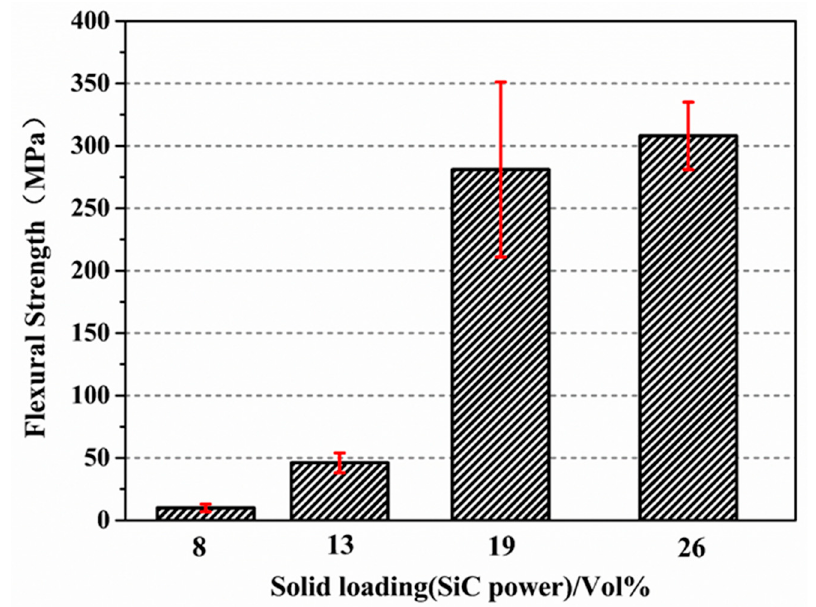
Figure 9. Flexural strengths of the joining specimens at room temperature with different solid loading (8%, 13%, 19%, 26%).